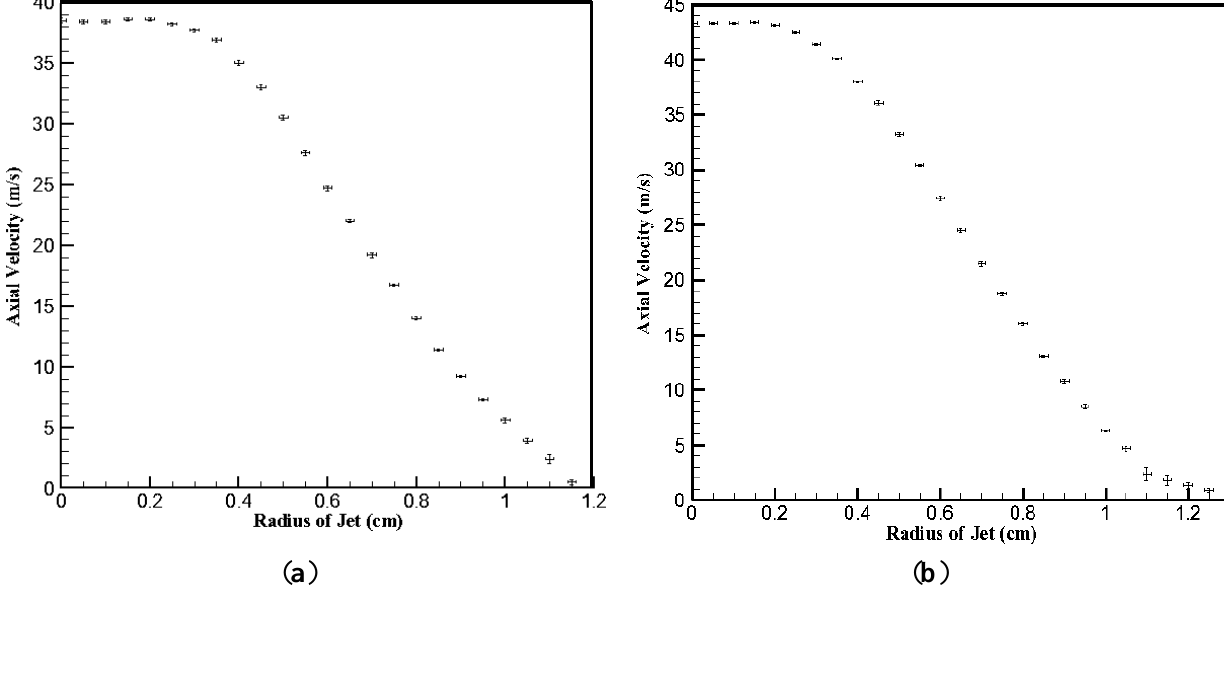
Figure 5. Axial velocity vs. radius for ( a ) Experiment 1 at z = 5 cm; ( b ) Experiment 2 at z = 5 cm; ( c ) Experiment 3 at z = 5